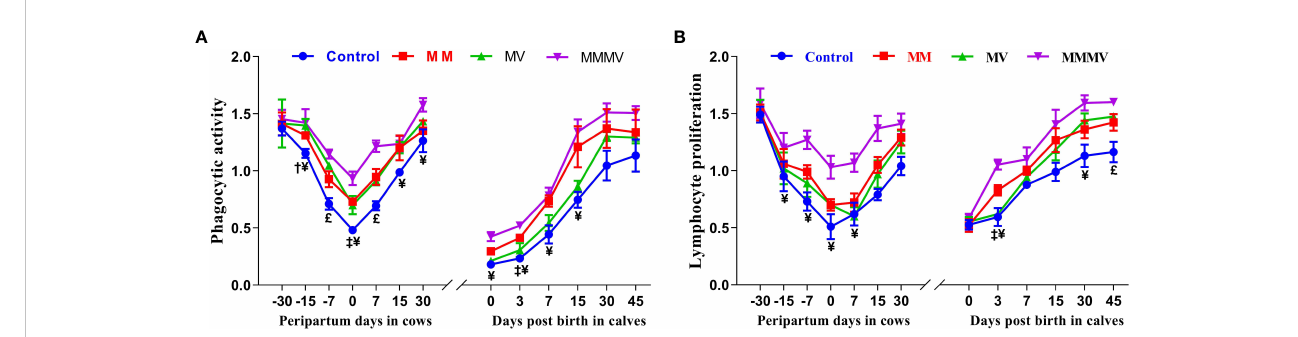
FIGURE 3 Phagocytic activity of neutrophils (PA, A) and lymphocytes proliferation (LPA, B) in control and treatment groups of crossbred cattle and their calves. Control: received basal diet only, MM: basal diet + injectable multimineral, MV: basal diet + injectable multivitamins, MMMV: basal diet + combination of injectable multimineral and multivitamins. The mean values with different superscript symbols represent signi fi cant differences with the control group at different days of peripartum in cows and post birth in calves; ‡ Control Vs MM, † Control Vs MV, ¥ Control Vs MMMV. £ Control Vs MM, MV and MMMV.